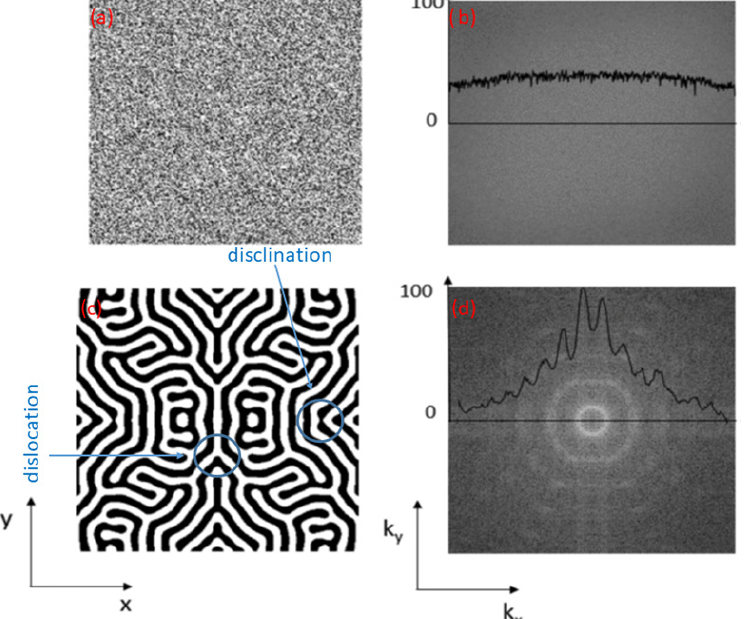
Figure 3. Radiation-induced patterns simulated via the phase field approach of Ag 0.38 Cu 0.62 . The initial solid solution (graph a ) leads to a labyrinthine structure (graph c ) after irradiation with 1 MeV Kr ions at φ = 6 × 10 12 cm − 2 s − 1 , and T = 440 K. Associated Power Spectral Density | S ( k , t ) | 2 in the Fourier space are also plotted (graphs b , d ). In these simulations, A rich (black) (B rich (white)) domains are associated with positive (negative) σ values (the 3D domain size is equal to 200 in reduced units). The PSD is radially symmetric and peaks sharply around k 0 (intense white ring in graph d ) as expected for a patterning whereas it is flat as expected for a random distribution of atoms (graph b ). On the 2D cut of the 3D pattern (graph c ), extended defects such as disclination and geometrical dislocation lines are clearly